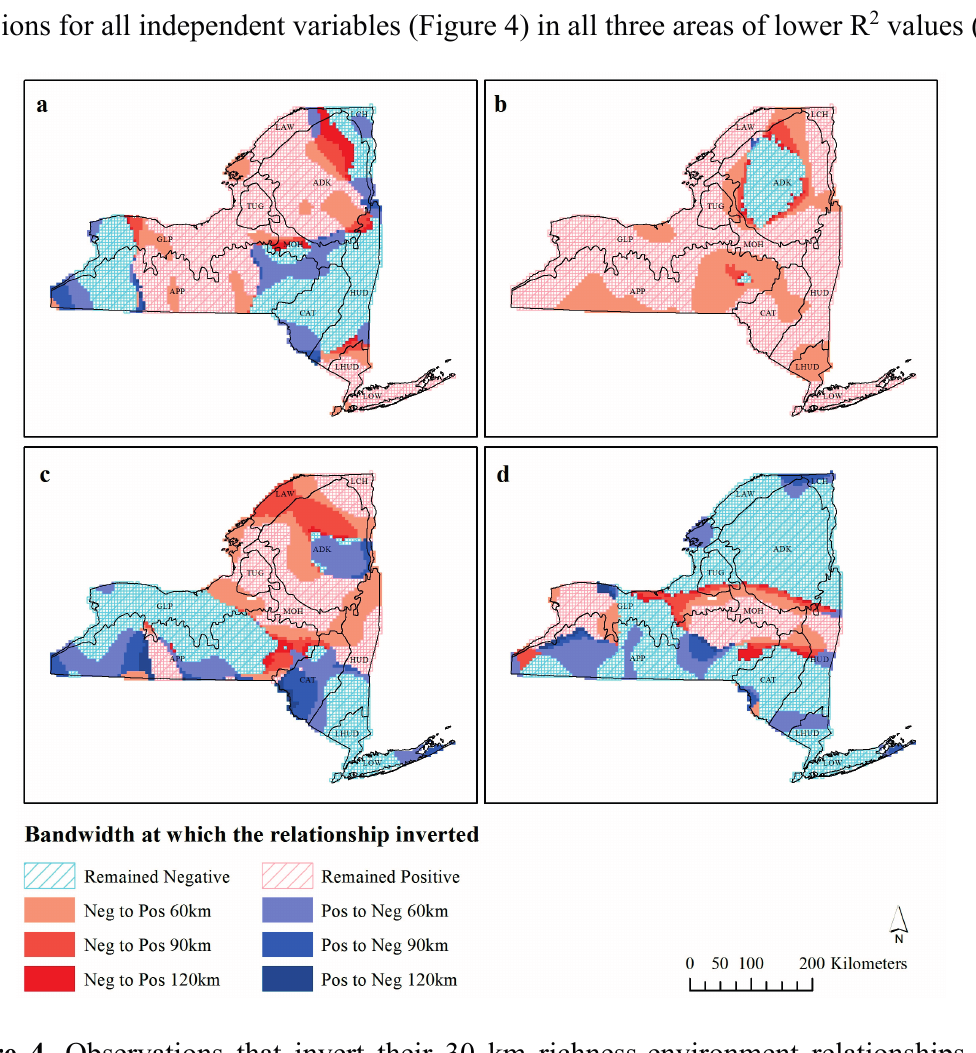
Figure 4. Observations that invert their 30 km richness-environment relationships with increasing scale for ( a ) precipitation, ( b ) Enhanced Vegetation Index (EVI), ( c ) temperature, and ( d )